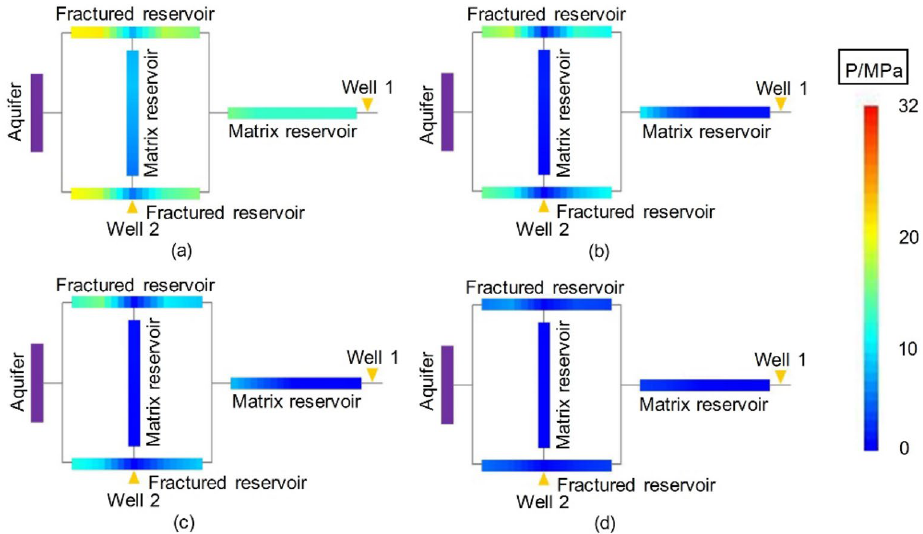
Figure 15. Pressure distributions at different stages of Experiment 2-1 (Well 2 is at Point A): ( a ) produced for 10 min, ( b ) produced for 20 min, ( c ) produced for 30 min, and ( d ) gas reservoir production halted at 135 min.